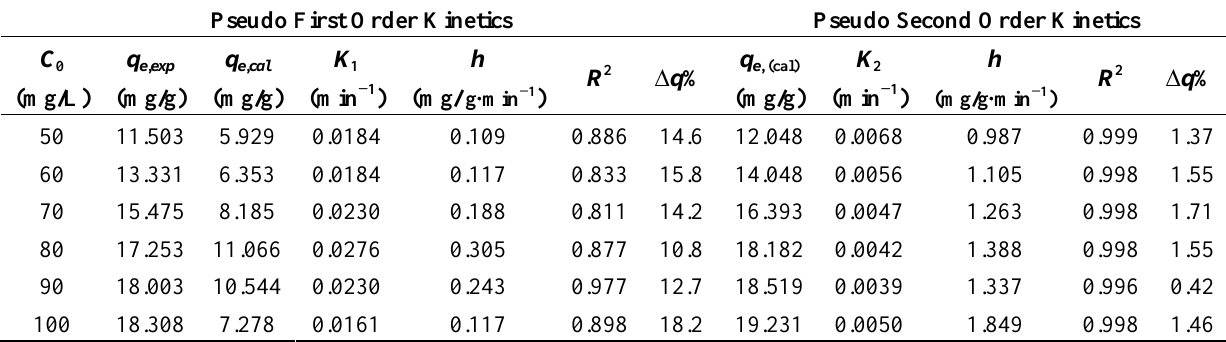
Table 3. The evaluation of pseudo first and pseudo second order kinetic parameters at 30